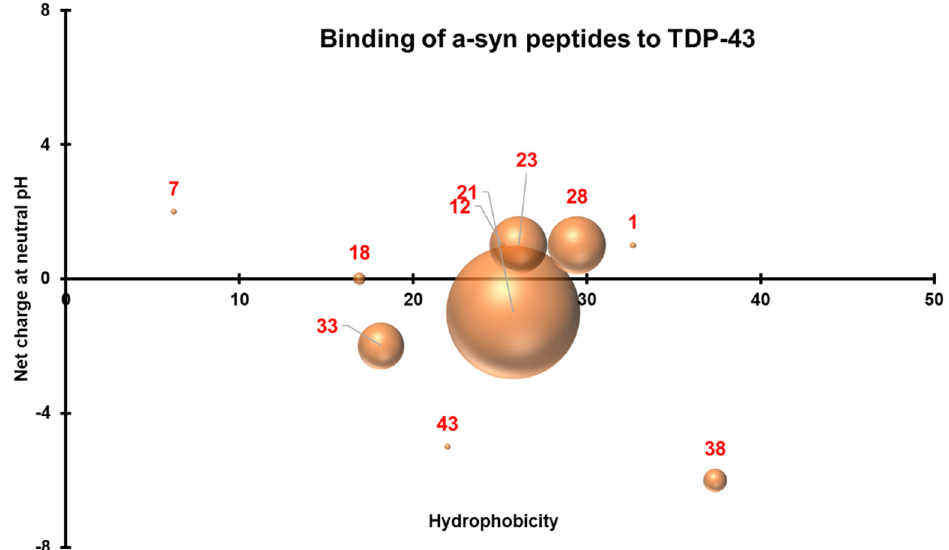
Figure 11. Three-dimensional scatterplot of α -synuclein peptides based on their hydrophobicity indices, net charge at pH 7.0, and their interactions with TDP-43. Peptides within the NAC region bound strongly to TDP-43.